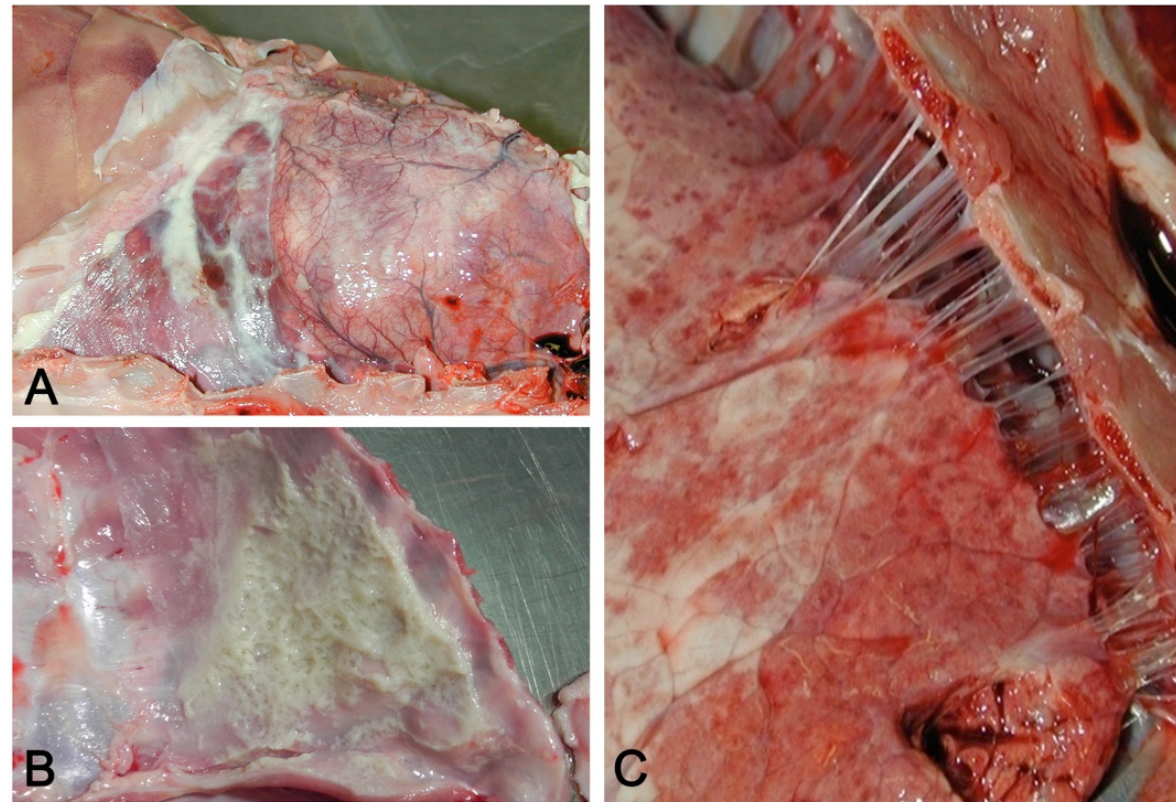
Figure 11. ( A ) Acute serofibrinous pleuritis and pericarditis: fibrinous exudate forms loosely adherent strands of material on the pleural surface. ( B ) Layers of fibrin covering the thoracic wall in acute serofibrinous pleuritis. ( C ) Chronic fibrous pleuritis with strongly adherent fibrous strands between the lung and thoracic wall.